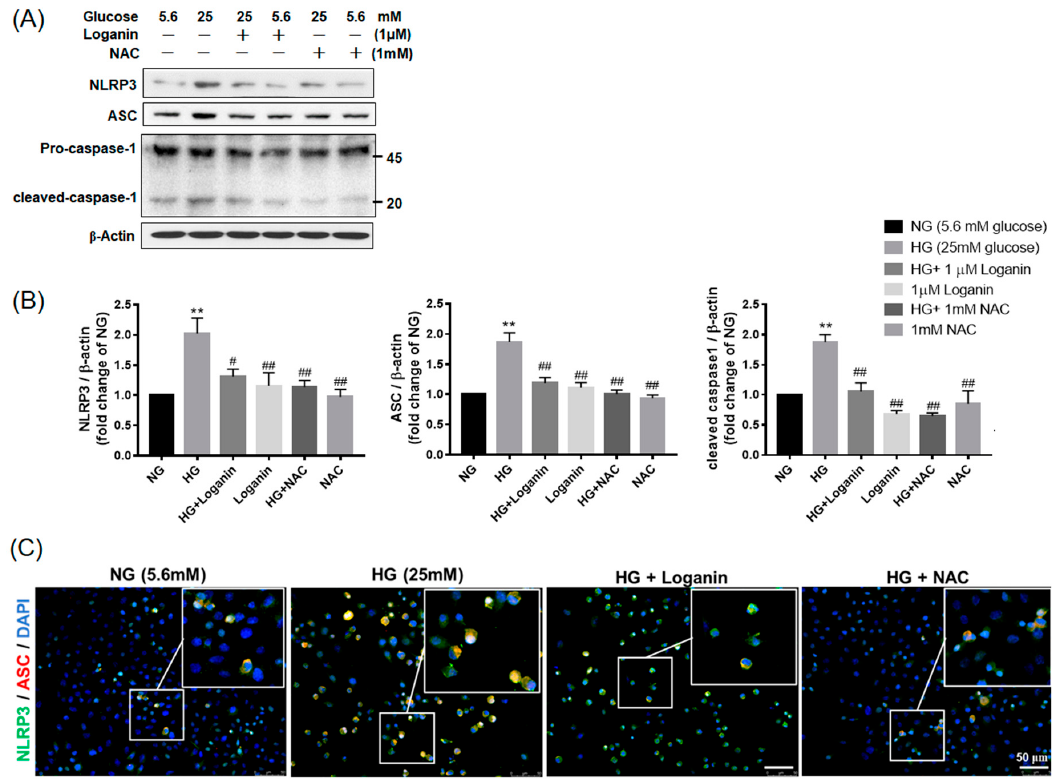
Figure 4. Loganin effects on NOD-like receptor protein 3 (NLRP3) inflammasome formation in high-glucose-treated rat RSC96 Schwann cells. ( A ) Western blot images show the expression of NLRP3, ASC and pro-/cleaved-caspase-1 protein in high-glucose-treated cells at 48 h; ( B ) relative fold changes of NG corresponding to (A). ** p < 0.01 vs. normal glucose (NG, 5.6 mM); # p < 0.05 and ## p < 0.01 vs. HG group. Data expressed as mean ± SEM, n = 3; ( C ) double-immunofluorescent labeling with NLRP3 (green) and ASC (red). Nuclei counterstained with DAPI. Merge revealed colocalization (yellow) in cells (inset). Magnification, ×200; scale bar, 50 μ m.